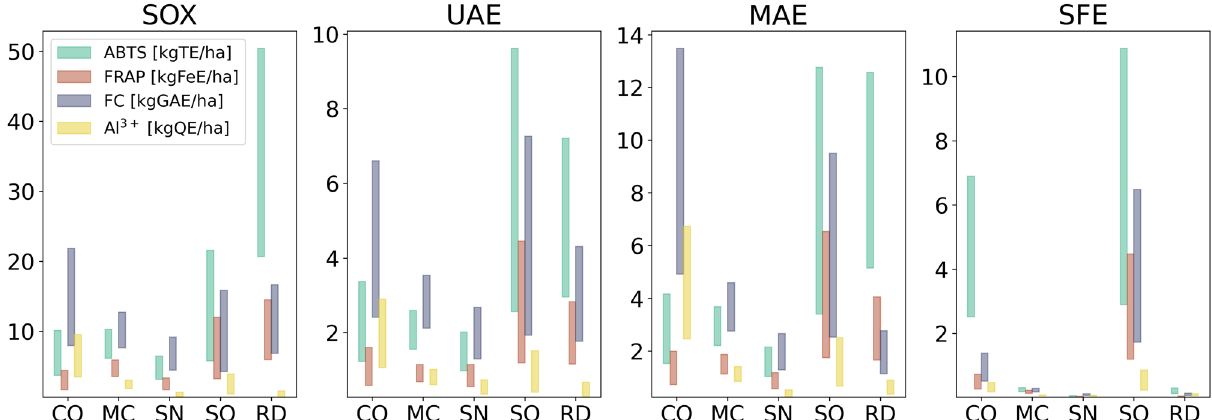
Figure 5. Potential yields of bioactive compounds, given as kilogram-equivalents of appropriate standard (see “Materials and methods” for details), per hectare of a given crop. The vertical bars denote the range of possible returns, as calculated using literature-reported crop yields of the five tested